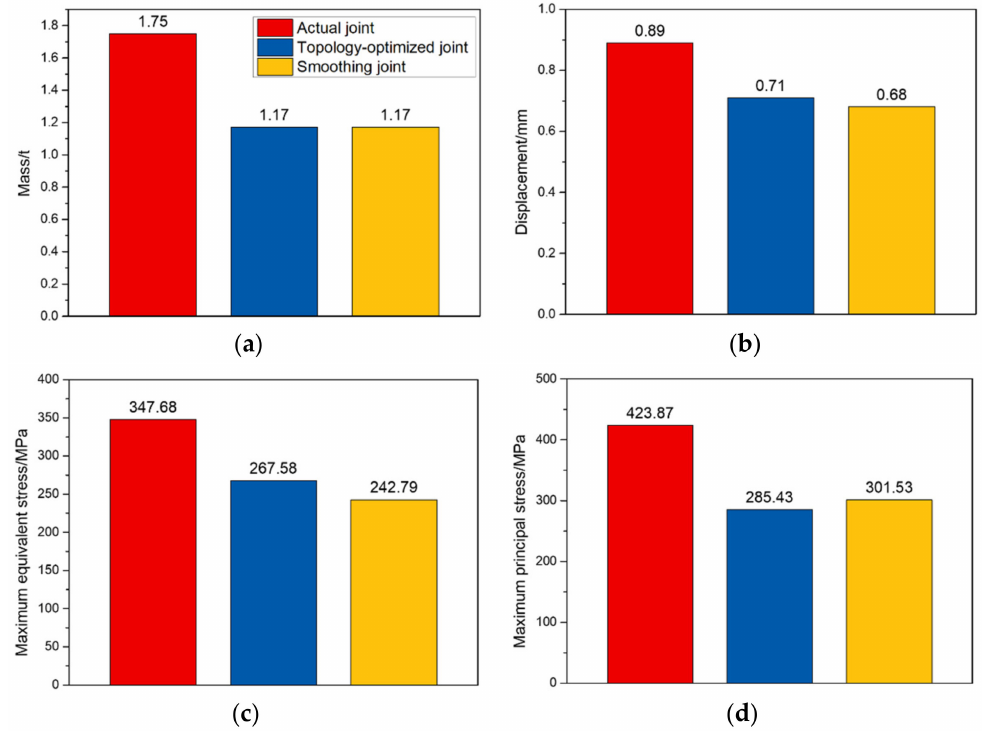
Figure 13. Histogram of the joint behavior: ( a ) mass; ( b ) displacement; ( c ) maximum equivalent stress; ( d ) maximum principal